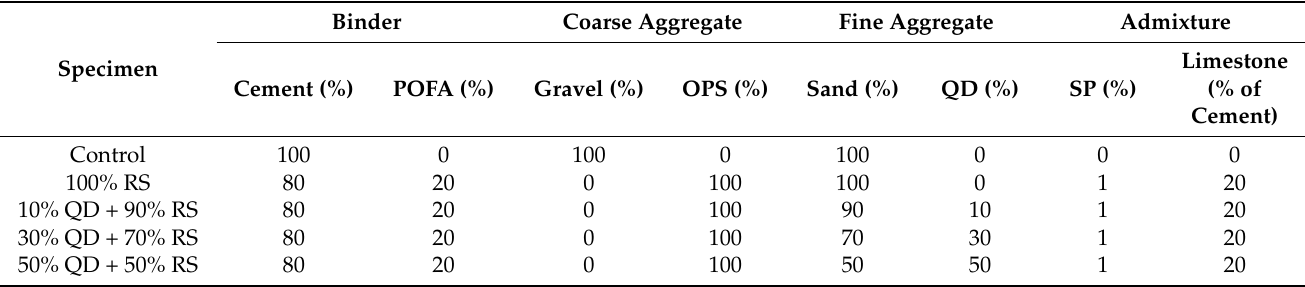
Table 4. Summary of mix design and proportion distribution for Phase